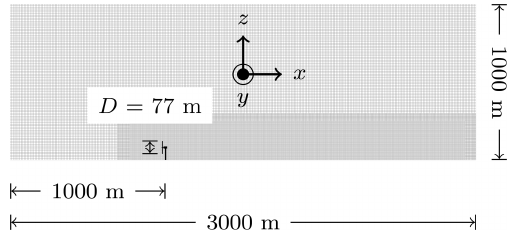
Figure 3. 1.5MW LES domain with turbine, mesh refinement zones, and grid spacing to scale. All dimensions in meters unless otherwise